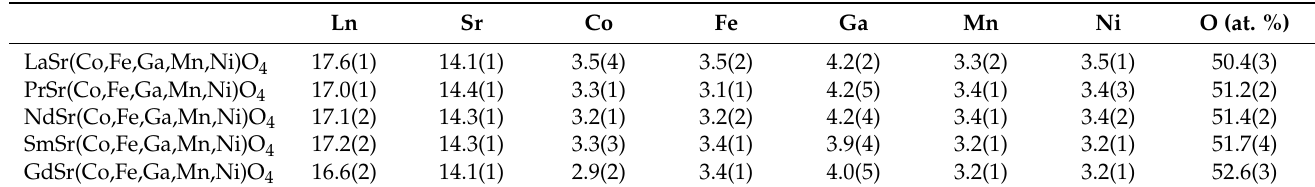
Table 2. The chemical composition of the studied LnSr(Co,Fe,Ga,Mn,Ni)O 4 (Ln = La, Pr, Nd, Sm, or Gd) series was determined by EDX area analysis. For each sample, three different areas were measured. Ln Sr Co Fe Ga Mn Ni O (at. %)